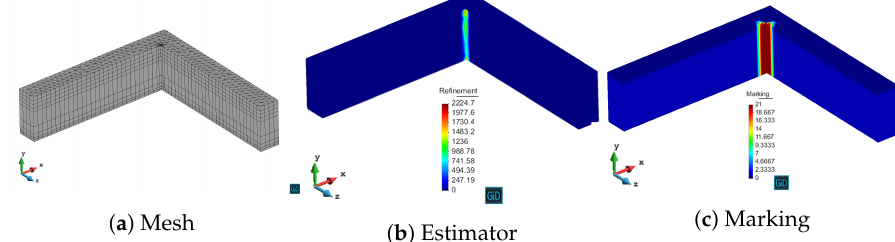
Figure 20. Third iteration for L-shaped problem with h